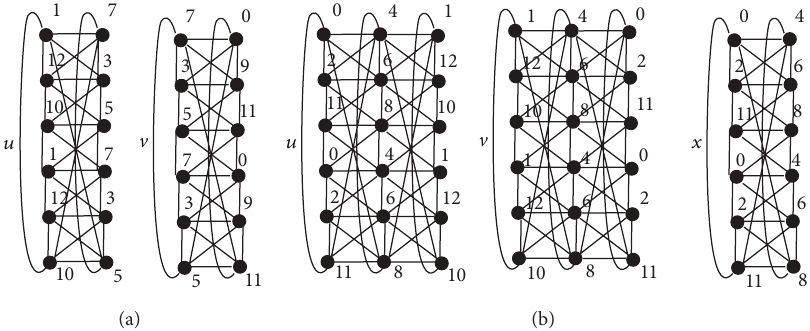
Figure 2: Two vertices of 𝐷 6,12 (a) and two vertices of 𝑉 3 6,12 with a vertex of 𝐷 2 6,12